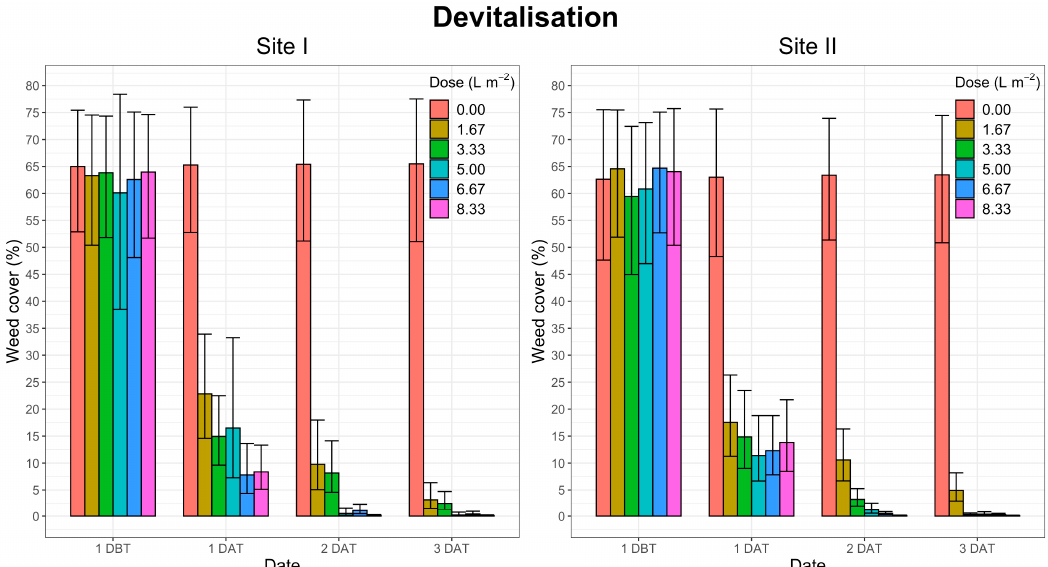
Figure 4. Devitalisation (i.e., from hot foam application to death of weeds) bar graph of back transformed means (Table 4) and the 95% confidence interval of weed cover percentage as affected by the foam dose (0, 1.67, 3.33, 5.00, 6.67, 8.33 L m − 2 ), the site and the evaluation date in the Taraxacum officinale (Weber) and Plantago lanceolata (L.) infested field experiment; 1 DBT, 1 DAT, 2 DAT and 3 DAT: one day before and one, two and three days after the treatment, respectively.